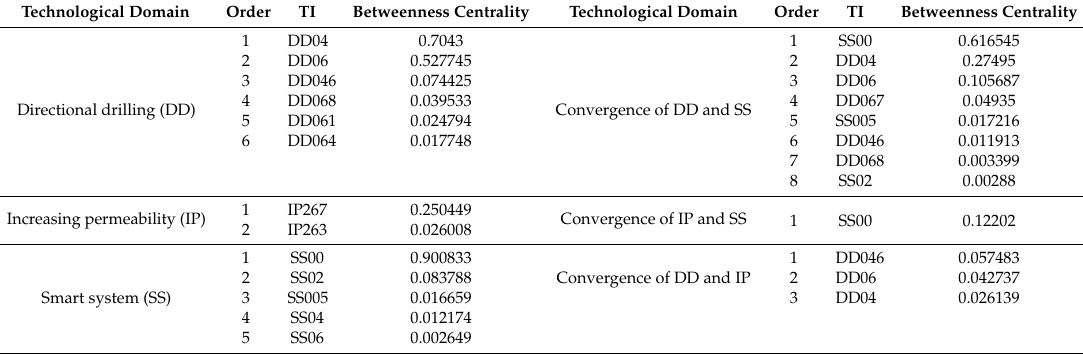
Table 6. Betweenness centrality by technological domains—2012 to